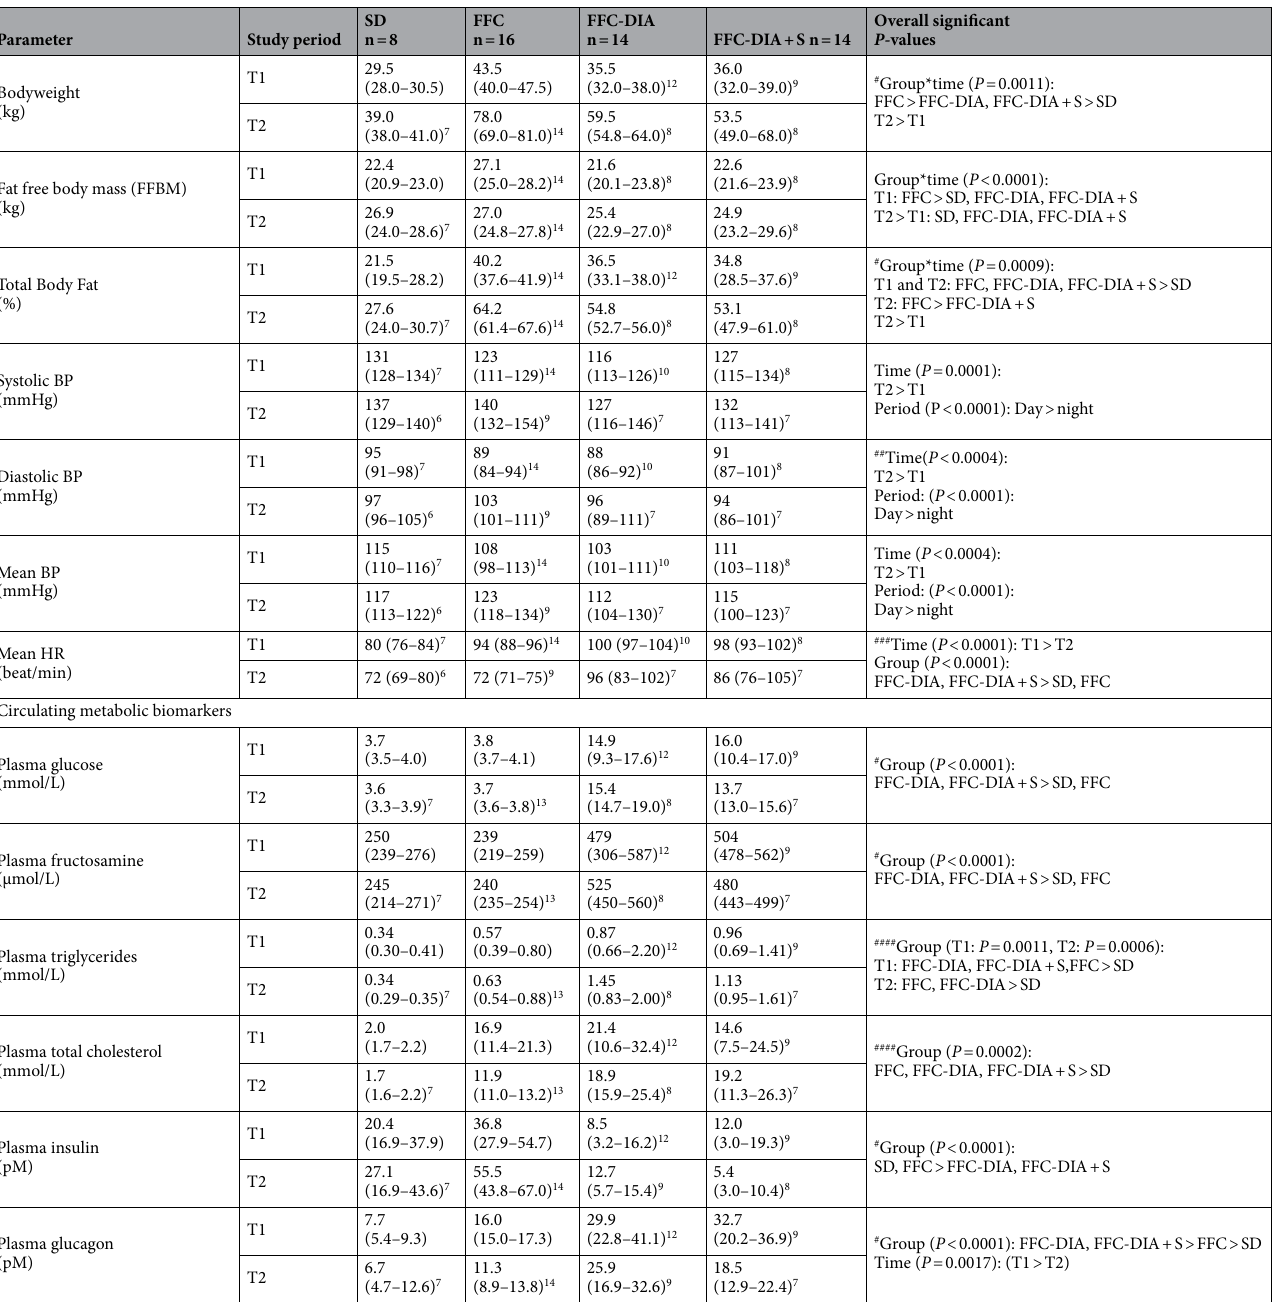
Table 1. Basic characteristics of castrated male Göttingen Minipigs fed with standard diet (SD) or fat, fructose and cholesterol rich diet (FFC) with or without additional salt (S) and with or without streptozotocin-induced diabetes (DIA). BP: Blood pressure, HR: Heart rate. Selected parameters were influenced by cohort: Body weight (CoA > CoB)( P = 0.024) and in addition plasma glucose ( P = 0.0072 (CoA > CoC)), triglycerides at T1 ( P = 0.048; CoA > CoC) ) and total cholesterol atT1 ( P = 0.010; CoA > CoC) and P = 0.029; CoB > CoC). T1: Approx. 7 months of diet-feeding, T2: Approx. 13 months of diet feeding. Median and interquartile range (Q1-Q3). P -values < 0.05 were considered significant. Superscript: Actual numbers included in the statistical analysis due to missing data. P-values from post hoc tests were adjusted using Bonferroni